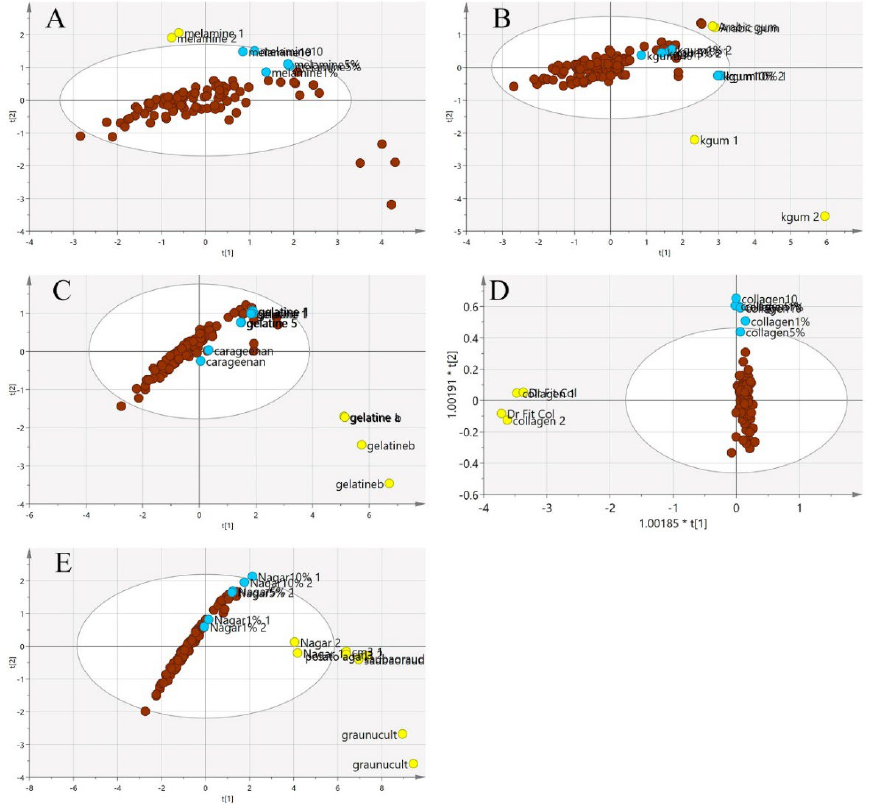
Figure 7. The three-class PCA-X score model is based on VIS/SW-NIR spectra (( A ) melamine, ( B ) karaya gum, ( C ) gelatine, ( D ) collagen and ( E ) nutrient agar). The authentic class is pure EBN samples, the adulterant class is the material for adulteration, and the adulterated sample is the EBNs with 1, 5 and 10% of an adulterant. The distribution of the class shows that the adulterant class had the most variation from the others (authentic: , adulterant: , adulterated: ).